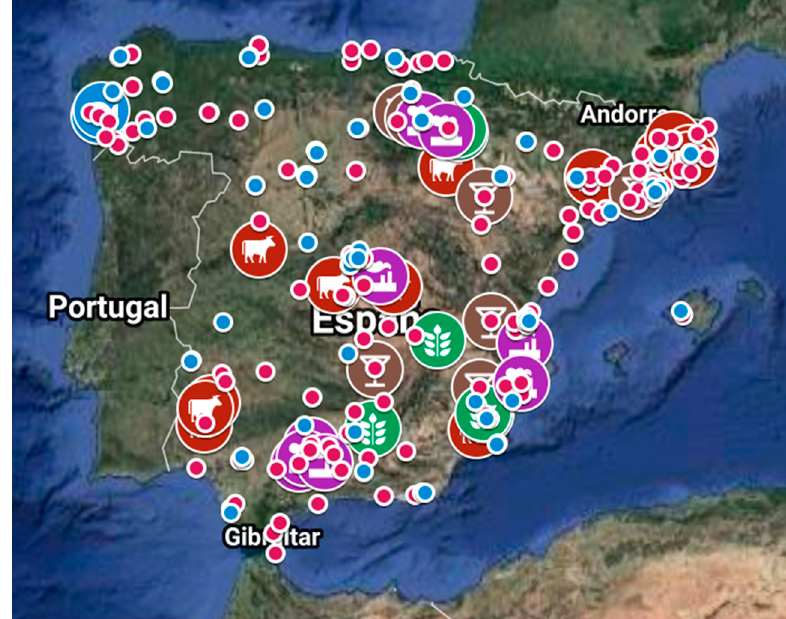
Figure 2. Food industrial districts and centers (universities and vocational training) that offer training programs for the food industry.